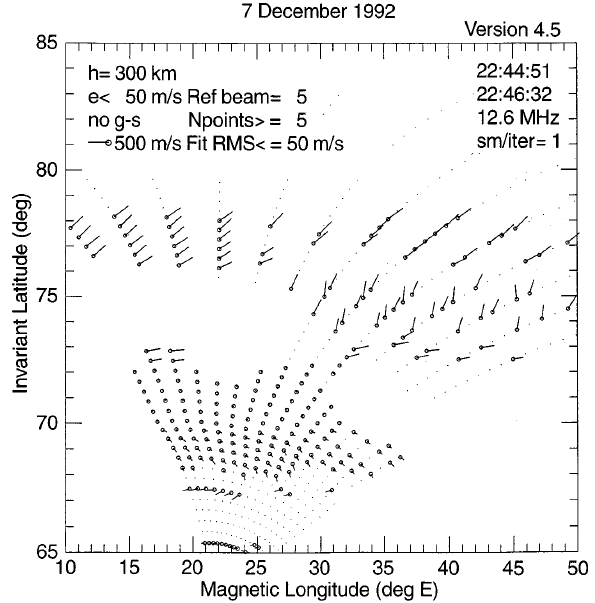
Fig. 11. Vectors showing direction and magnitude of the flow in the ionosphere deduced from the SuperDARN radar data at Goose